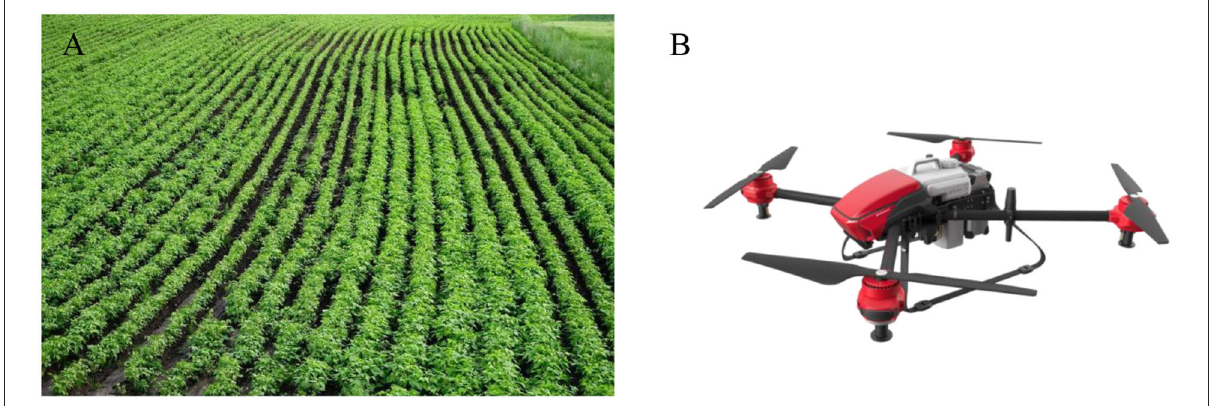
FIGURE1 (A) Formation application scenes. (B) Example for a multi-rotor plant protection UAV.